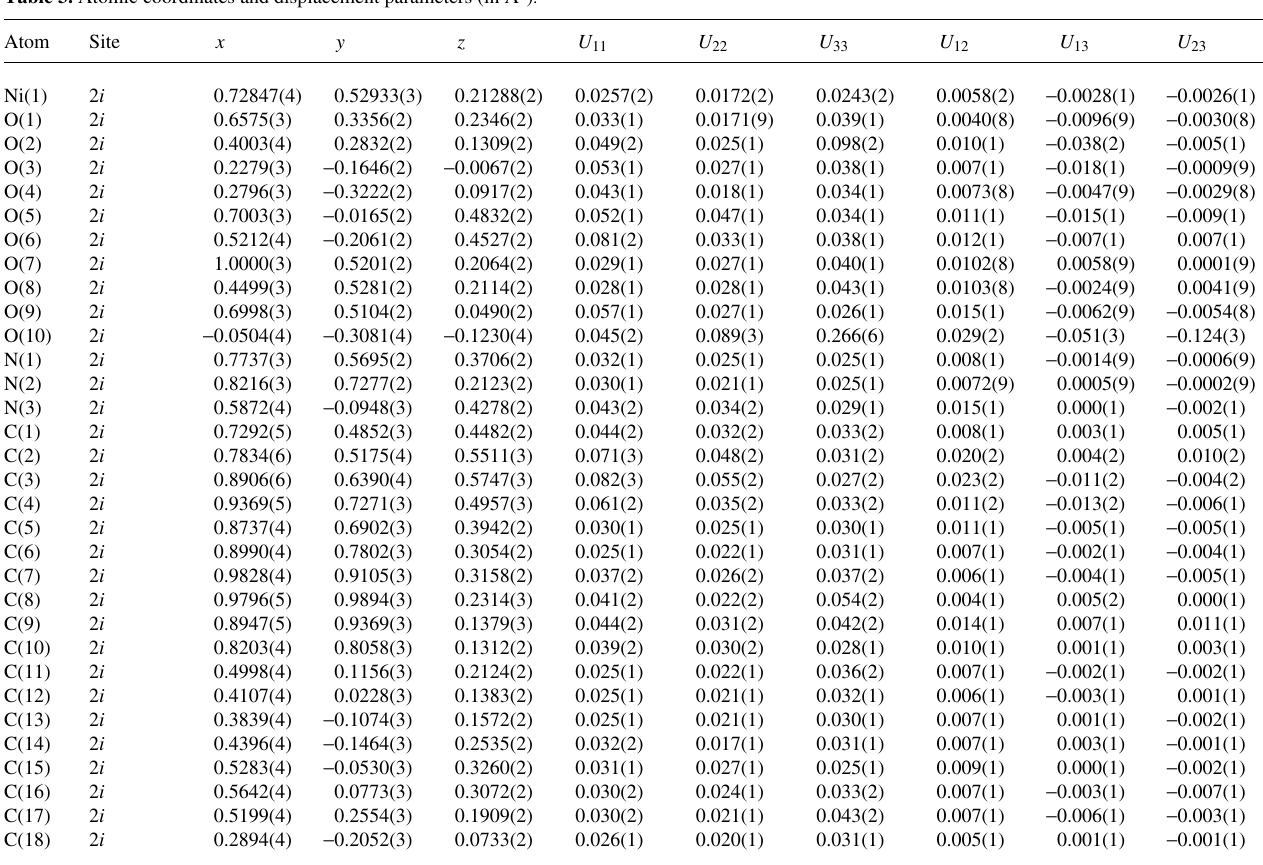
Table 3. Atomic coordinates and displacement parameters (in Å 2 )